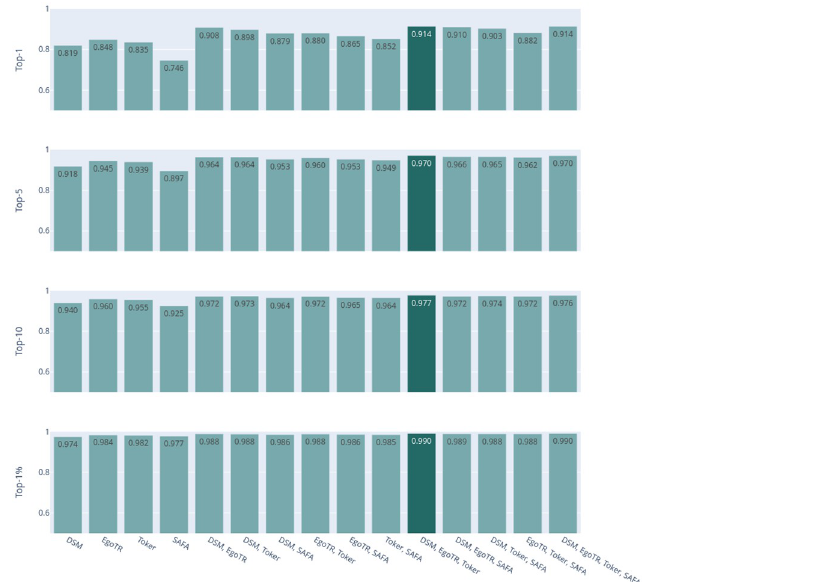
Fig 7. CVACT combinations for the soft-voting strategies.